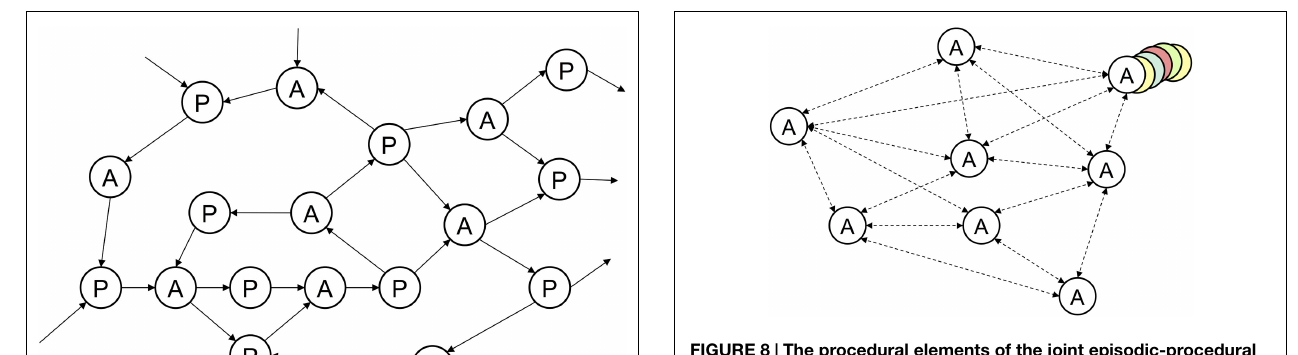
FIGURE 8 | The procedural elements of the joint episodic-procedural memory are drawn from procedural memory and, again, operate associatively in their own right . Such procedural memories are not static but are dynamic and adapt as the action is executed (top right).